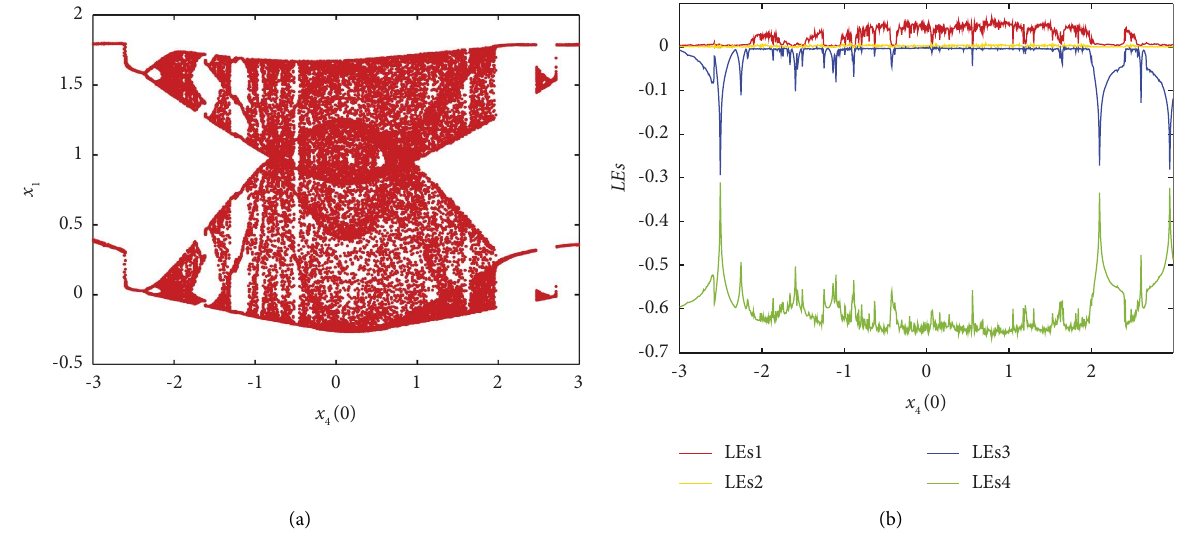
Figure 11: Initial value x